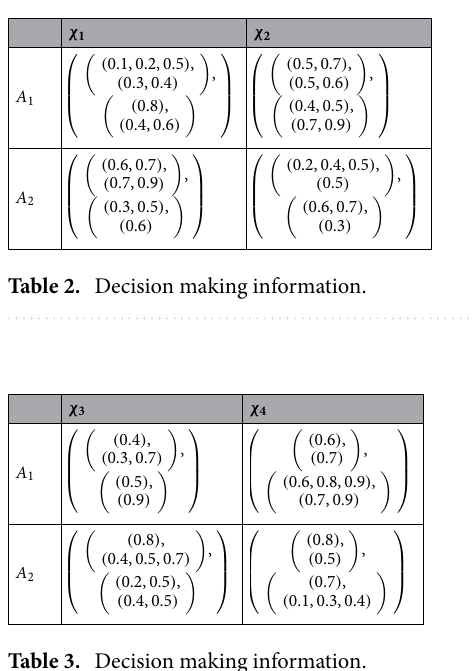
Table 3. Decision making information.